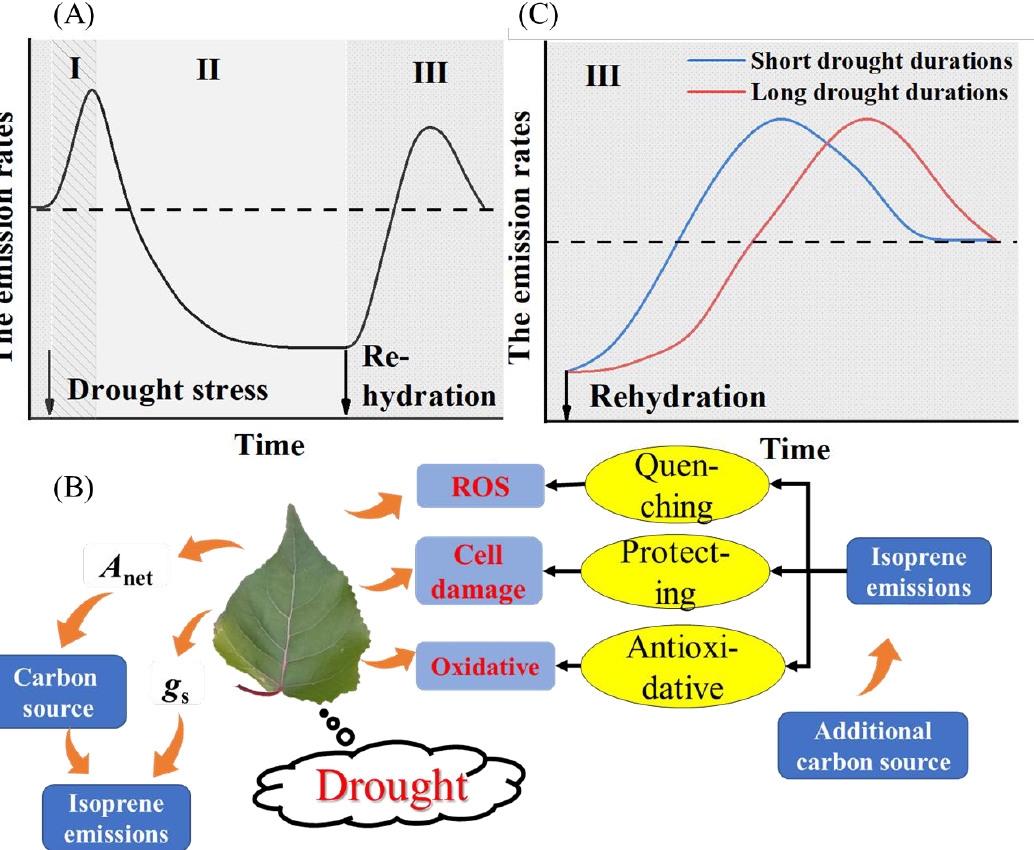
Figure 4. The response of BVOC emissions to the drought-rehydration cycle is divided into phases I, II and III. ( A ) shows the changes in BVOC emissions in phases I, II and III of the drought rewatering cycle. ( B ) shows the stimulation of BVOCs by drought stress in phase I. ( C ) shows the effect of short and long drought durations on the recovery rate of BVOCs in phase III.